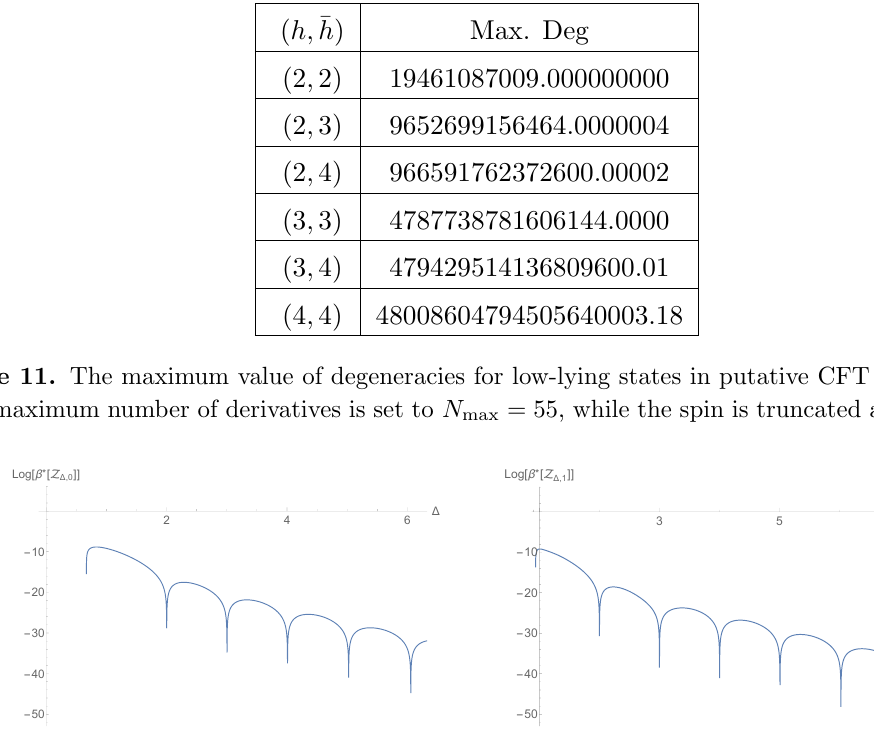
Figure 14. The extremal functional (cid:12) (cid:3) acting on spin-0 (left) and spin-1 (right) primaries at c = 8 and (cid:1) t = 1, without the spin-1 conserved